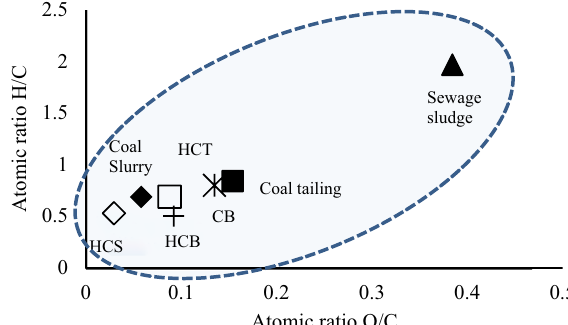
Figure 8. Van-Krevelen diagram for untreated, HTC, and Co-HTC